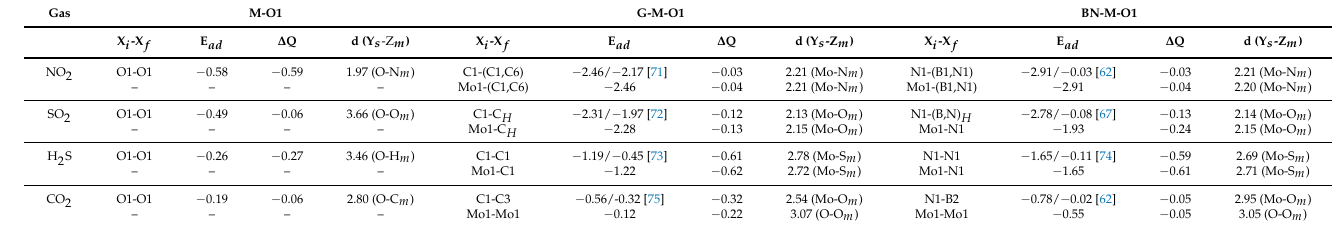
Table 3. X i -X f refers to the adsorbed site before-after relaxation, E ad is the adsorption energy (eV). The closest distance between the sheet and an adsorbent is d(Y s -Z m ) (Å), where Y s and Z m indicate the sheet atom and adsorbent atom, respectively, and ∆ Q (e) refers the charge transfer where the negative sign means charge is transferred from the structure to an adsorbent. C H and (B,N) H refer to the final position located at the hexagonal ring of G and h -BN, respectively. The references in the adsorption energy columns refer to the corresponding values of the adsorbent gases on the pristine G and h -BN monolayers.